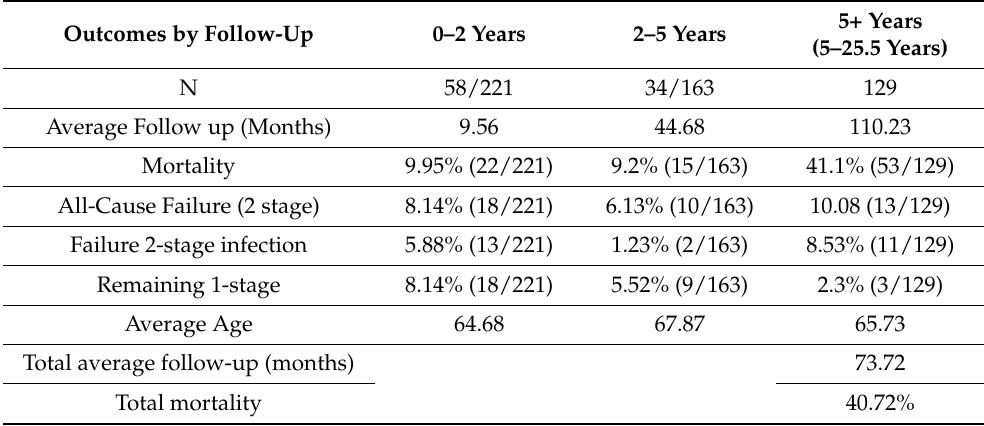
Table 2. Outcomes by follow-up.